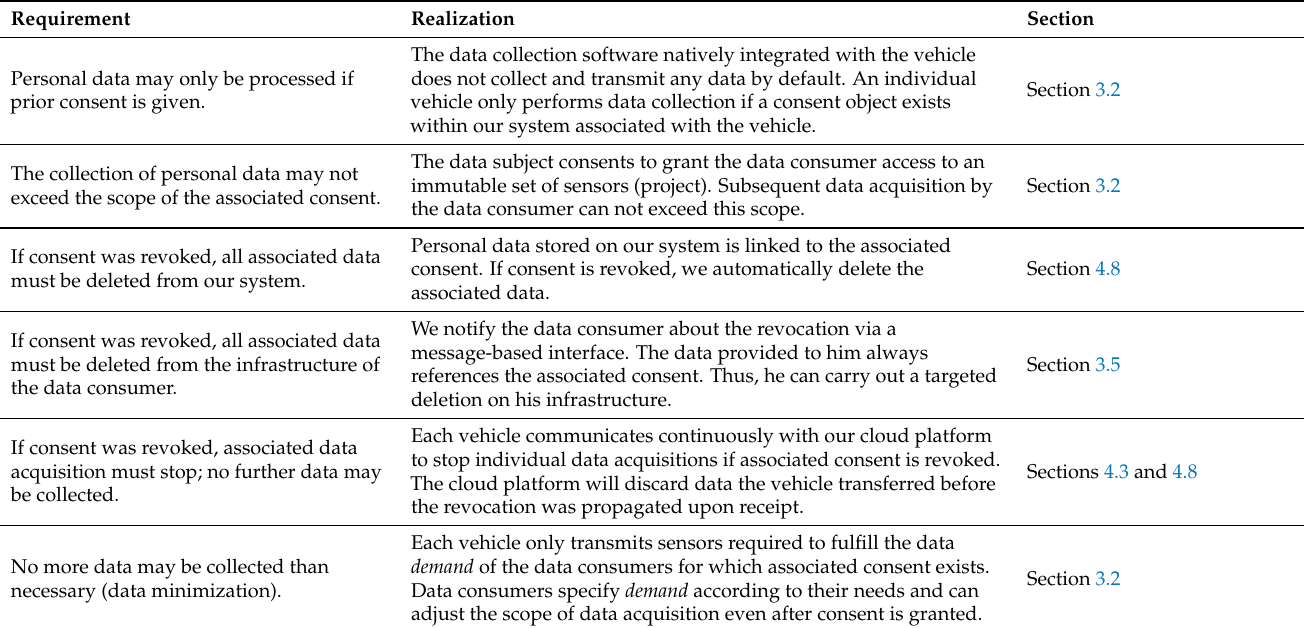
Table 2. Requirements for the processing of personal data derived from the